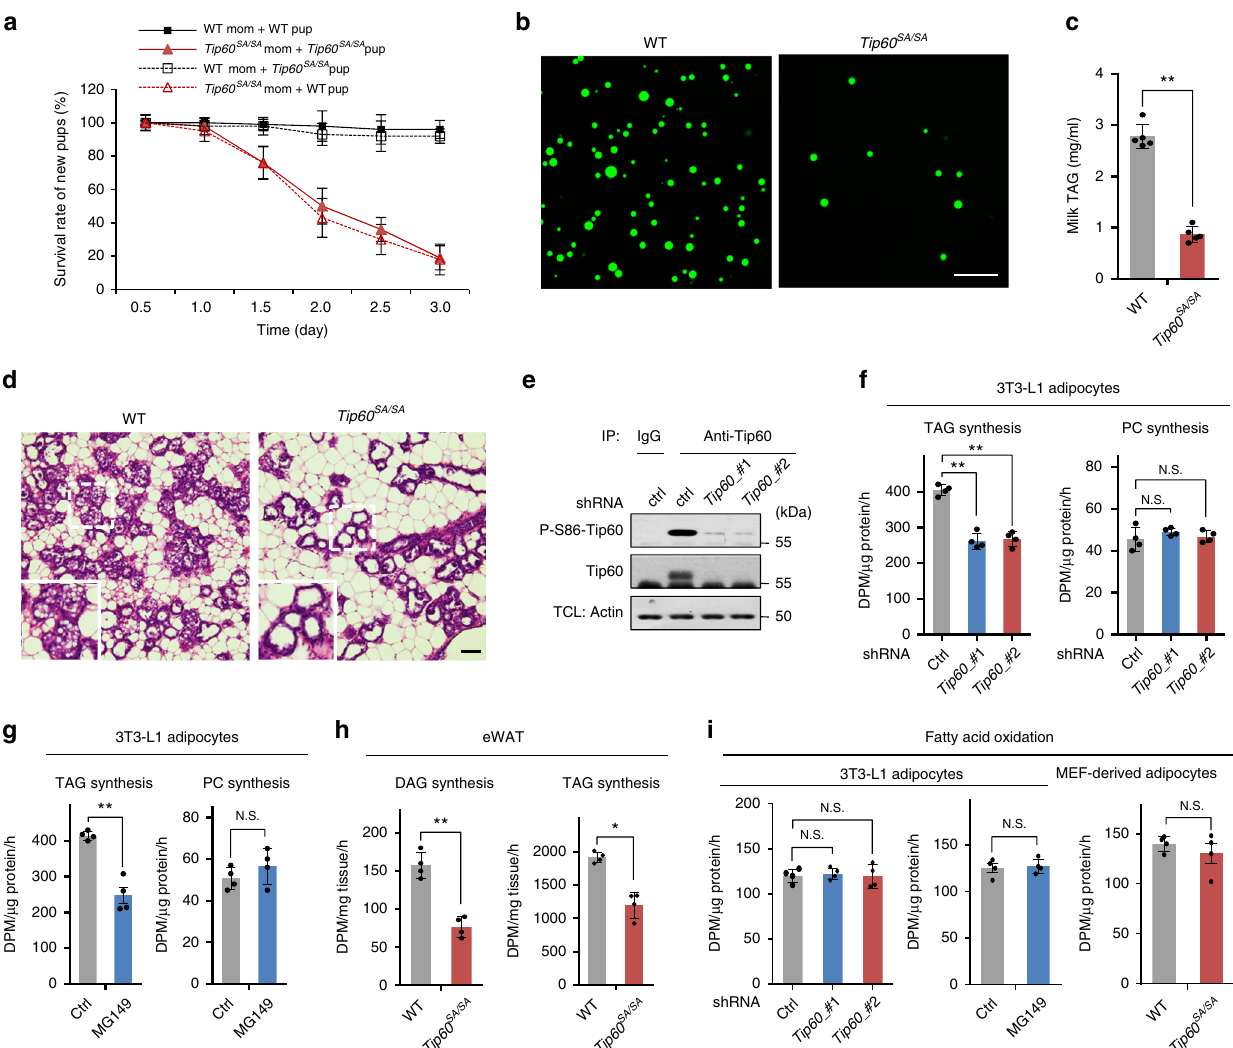
Fig. 2 Tip60 plays an essential role in fatty acid-induced TAG synthesis. a Survival rates of Tip60 SA/SA litters nursed by WT or Tip60 SA/SA females ( n = 8 litters for each group), and WT litters nursed by WT or Tip60 SA/SA females ( n = 7 litters for each group). b Representative BODIPY staining ( n = 3 experiments) of milk fat globules (green) from the mammary glands of early lactating (day 2 postpartum) WT and Tip60 SA/SA females. Scale bar, 50 μ m. c Level of TAG in milk collected from WT and Tip60 SA/SA females (day 2 postpartum, n = 5 per group). d Representative images of mammary glands from WT and Tip60 SA/SA females at day 2 postpartum ( n = 3 experiments), visualized by H&E staining. The WT mouse (left) has numerous fat globules in the apical regions of mammary epithelial cells and in the ductal lumens, but were rare in the Tip60 SA/SA mouse (right). Scale bars, 50 μ m. e Lentivirus- mediated knockdown of Tip60 in 3T3-L1 adipocytes. TCL total cell lysate. f TAG and phosphatidylcholine (PC) synthesis rates of 3T3-L1 adipocytes expressing control shRNA (ctrl) or shRNAs targeting Tip60 with 3 H-labeled oleic acid (OA) treatment ( n = 4 experiments). g TAG and PC synthesis rates of 3T3-L1 adipocytes treated with DMSO (ctrl) or Tip60 inhibitor MG149 ( n = 4 experiments). h Rates of diacylglycerol (DAG) and TAG synthesis from 3 H-OA in eWAT explants isolated from 6-week-old WT and Tip60 SA/SA mice ( n = 4 individuals per group). i Fatty acid oxidation rates of control (ctrl) or Tip60 knockdown or MG149-treated 3T3-L1 adipocytes or adipocytes derived from WT or Tip60 SA/SA MEFs (day 8) ( n = 4 experiments). Error bars denote SEM. Statistical analysis was performed by two-tailed unpaired Student ’ s t -test in c , g , h and middle and right bar graph of i , by one-way ANONA followed by Tukey in f and left bar graph of i . * P < 0.05; ** P < 0.01; N.S. not signi fi cant. Uncropped blots can be found in Supplementary Fig. mouse embryonic fi broblasts (MEFs) from Tip60 SA/SA and WT differentiated 3T3-L1 adipocytes by two separate short hairpin RNAs (shRNAs) (Fig. 2e). We found that depletion of mice to differentiate into adipocytes. Surprisingly, primary MEFs Tip60 strongly impeded the synthesis of TAG as determined by or adipose stromal vascular fi broblasts (SVFs) from Tip60 SA/SA mice demonstrated a similar capacity in adipogenic differentia- using 3 H-labeled oleic acid (OA), while phosphatidylcholine (PC) synthesis was unaffected (Fig. 2f). Similar results were obtained tion compared to WT MEFs, with robust induction of adipogenic after treating 3T3-L1 adipocytes with MG149 22 , a small-molecule transcription factors PPAR γ and CCAAT/enhancer binding inhibitor of Tip60 (Fig. 2g). Moreover, the incorporation of 3 H- protein β (C/EBP β ), and key adipocyte proteins including fatty labeled OA into DAG or TAG was markedly reduced in acid synthase (FASN), stearoyl-CoA desaturase-1 (SCD1) and epididymal white adipose tissue (eWAT) explants from perilipin in both WT and Tip60 SA/SA MEFs/SVFs (Supplementary Tip60 SA/SA mice compared to WT controls (Fig. 2h and Fig. 2b – d). However, adipocytes derived from the Tip60 SA/SA Supplementary Fig. 2a). We also checked the ability of primary MEFs exhibited compromised accumulation of labeled DAG and